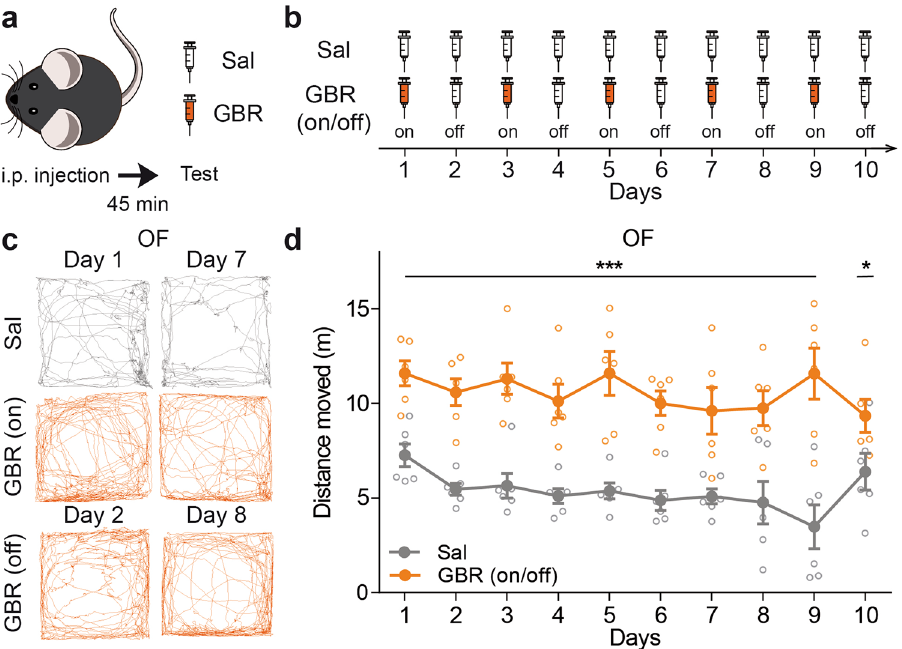
Figure 1. GBR administration induces strong hyperlocomotion. ( a ) Either GBR 12909 (GBR), 16 mg/kg, or saline (Sal) was injected intra-peritoneally (i.p.) 45 min before behavioral testing. ( b ) GBR was administered every other day (“on”), alterned with saline (“off”) during 10 days to obtain a sub-chronic model for mania. ( c ) Representative animal track for the 5 first minutes of the Open field test (OF). One same animal is showed for Sal group on days 1 and 7, and for the GBR group on days 1, 7 (“on”) and days 2 and 8 (“off”). ( d ) OF revealed sustained hyperlocomotion in the GBR (on/off)-treated mice compared with the Sal-treated mice over 10 days (two-way repeated measures ANOVA, group: F (1,10) = 45.42, ***p < 0.001, days: F (9,90) = 1.98, p = 0.050, interaction: F (9,90) = 1.91, p = 0.060, n = 6). Data are shown as mean ± SEM and individual data